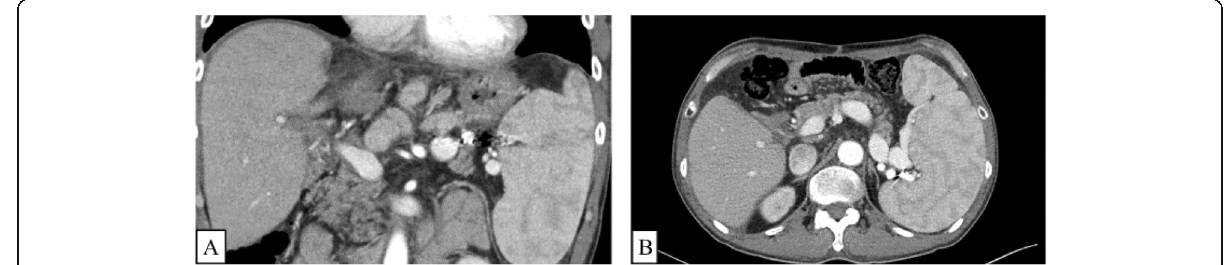
Fig. 4 Post-transplant PVT was disappeared after the administration AT III ( a and b